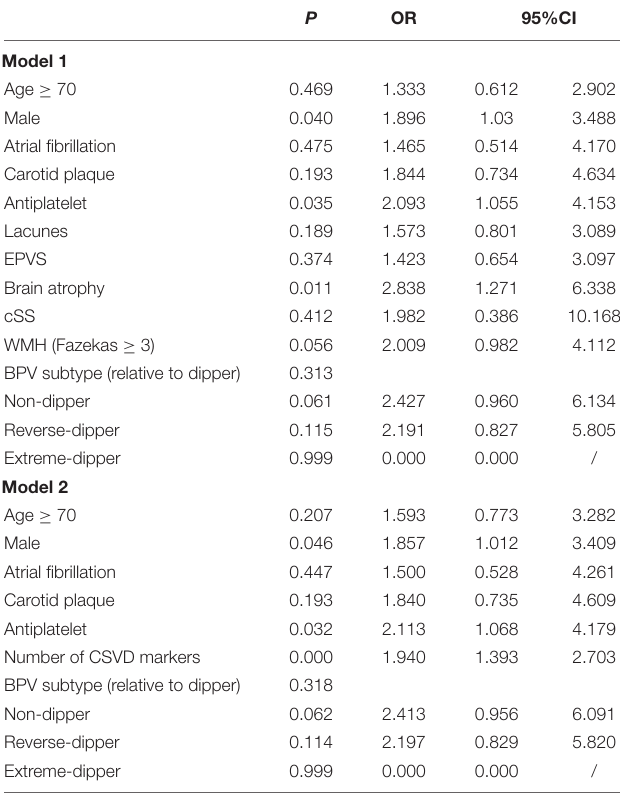
CSVD, cerebral small vascular disease; WMH, white matter hyperintensities; EPVS, enlarged perivascular space; cSS, cortical superficial siderosis; BPV, blood pressure variability; OR, odds ratio; CI, confidence interval.